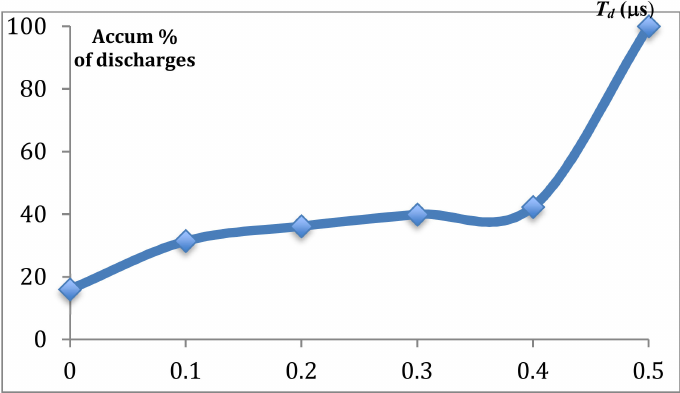
Figure 5. Abbot-Firestone curve of accumulated occurrence of types of discharge as a function of T d ( µ s).